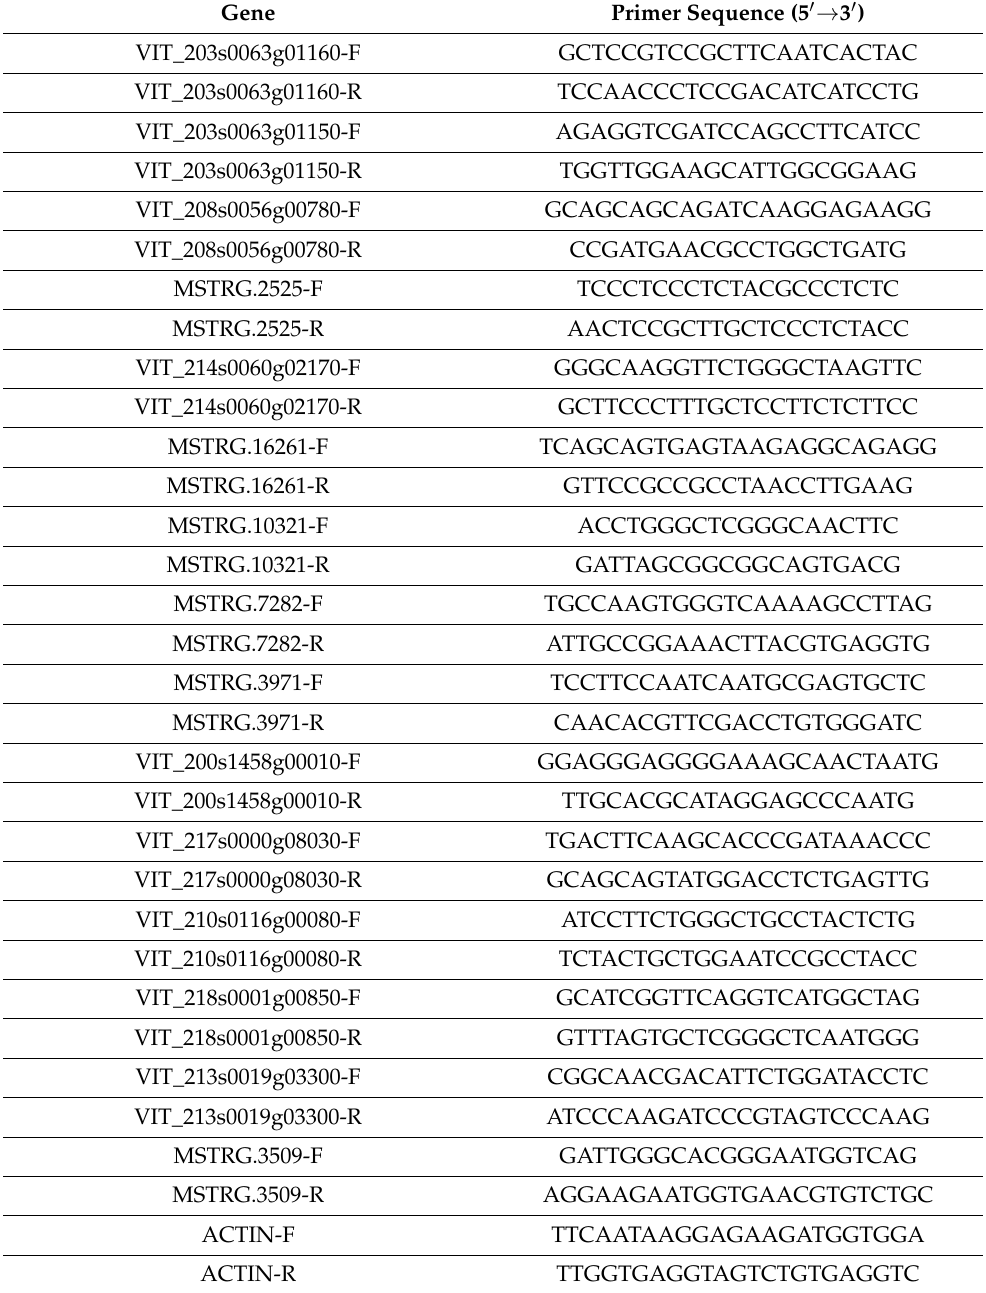
Table 1. Primers used for the RT-qPCR to confirm the transcription result of random genes obtained by RNA-seq.